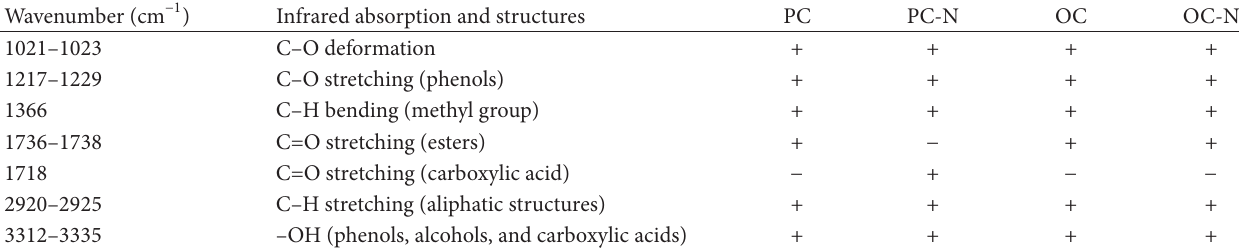
T 2: e main atomic groups and structures of adsorbents.